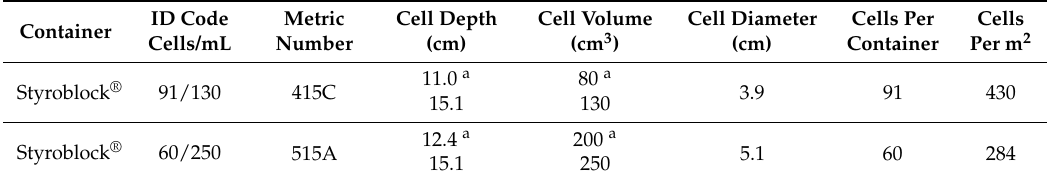
Table 1. Container specifications used to produce Douglas fir and western larch seedlings. Two types of containers were used to create four container treatment